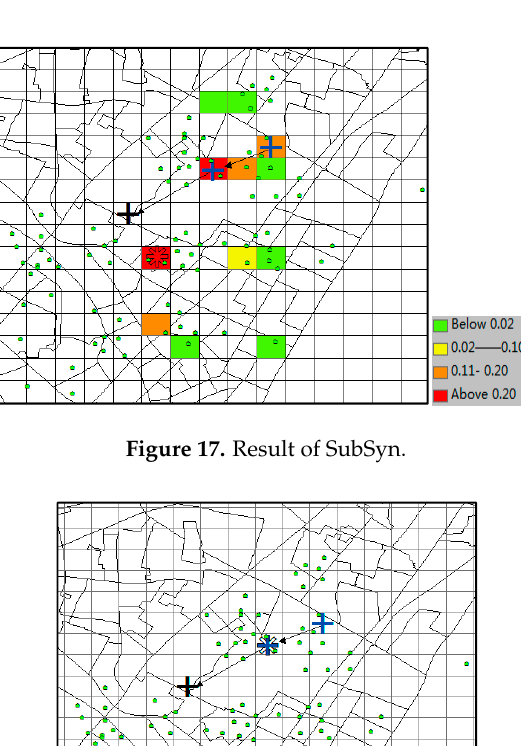
Figure 16. Result of CMoB.